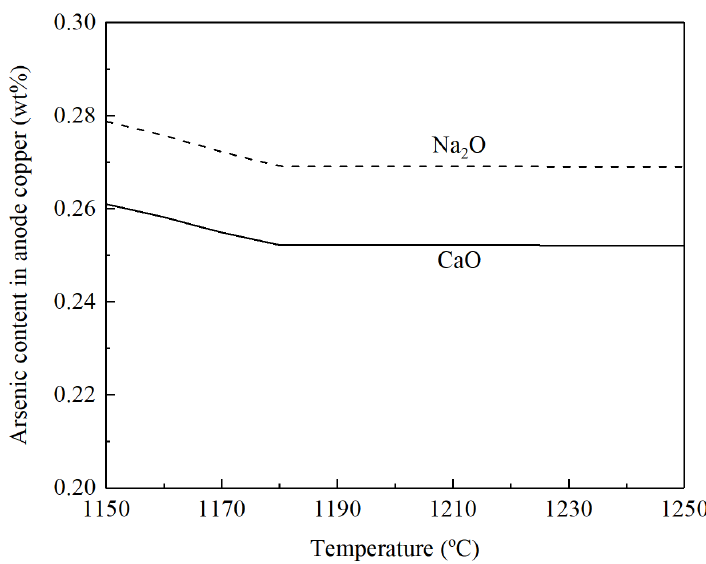
Figure 9. Effect of temperature on arsenic content in anode copper with 1.5% O 2 /blister and 0.2% flux/blister. flux/blister.